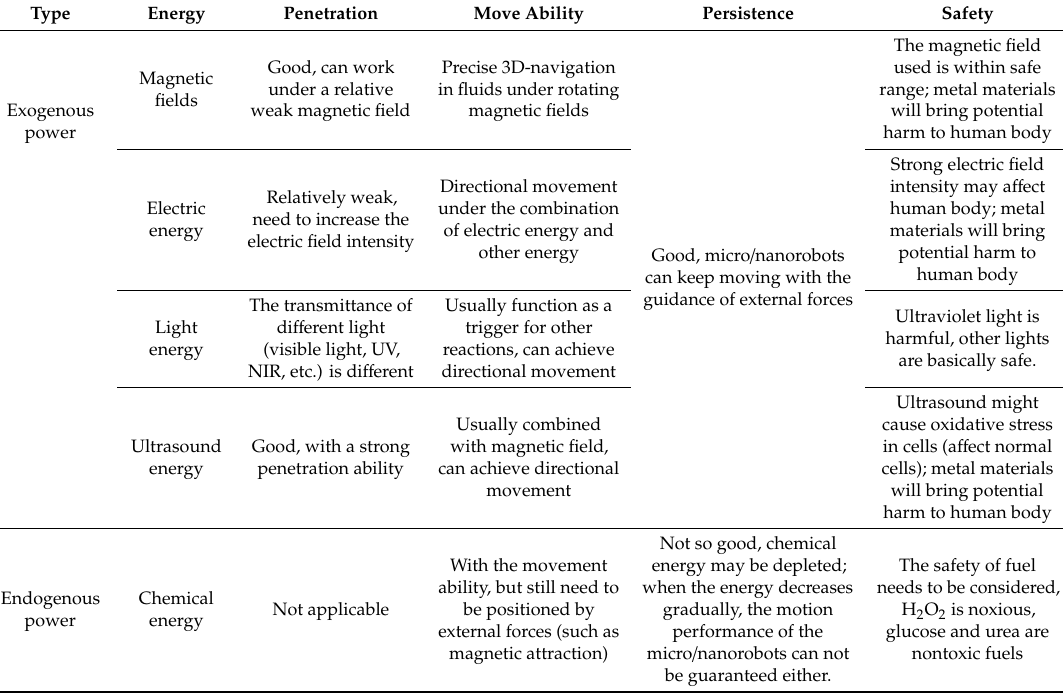
Table 1. Comparison of exogenous and endogenous power-driven micro /